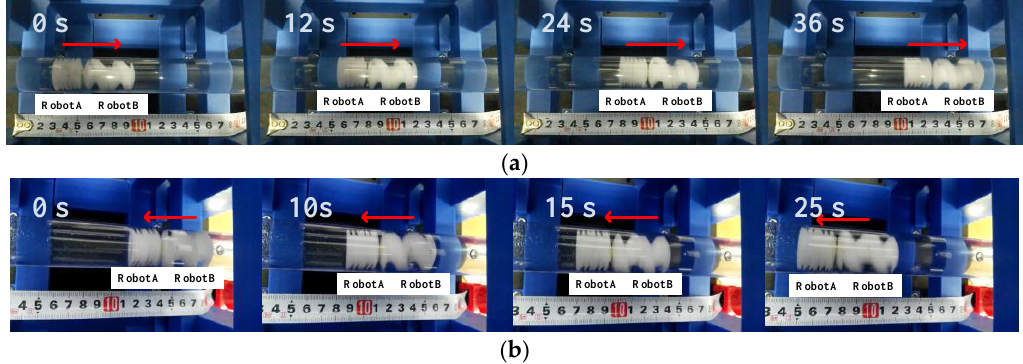
Figure 13. The video snapshots of cooperative locomotion: ( a ) forward locomotion of the whole; ( b ) backward locomotion of the whole.